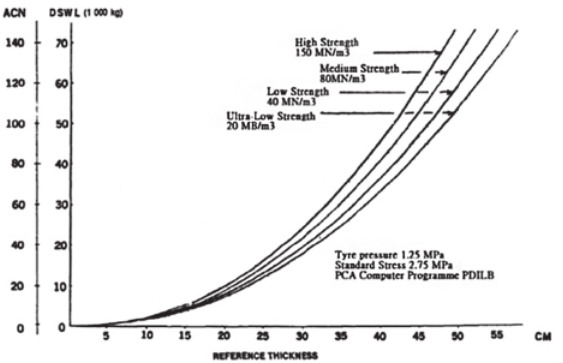
Fig. 2. ACN rigid pavement conversion chart (International … 1983)